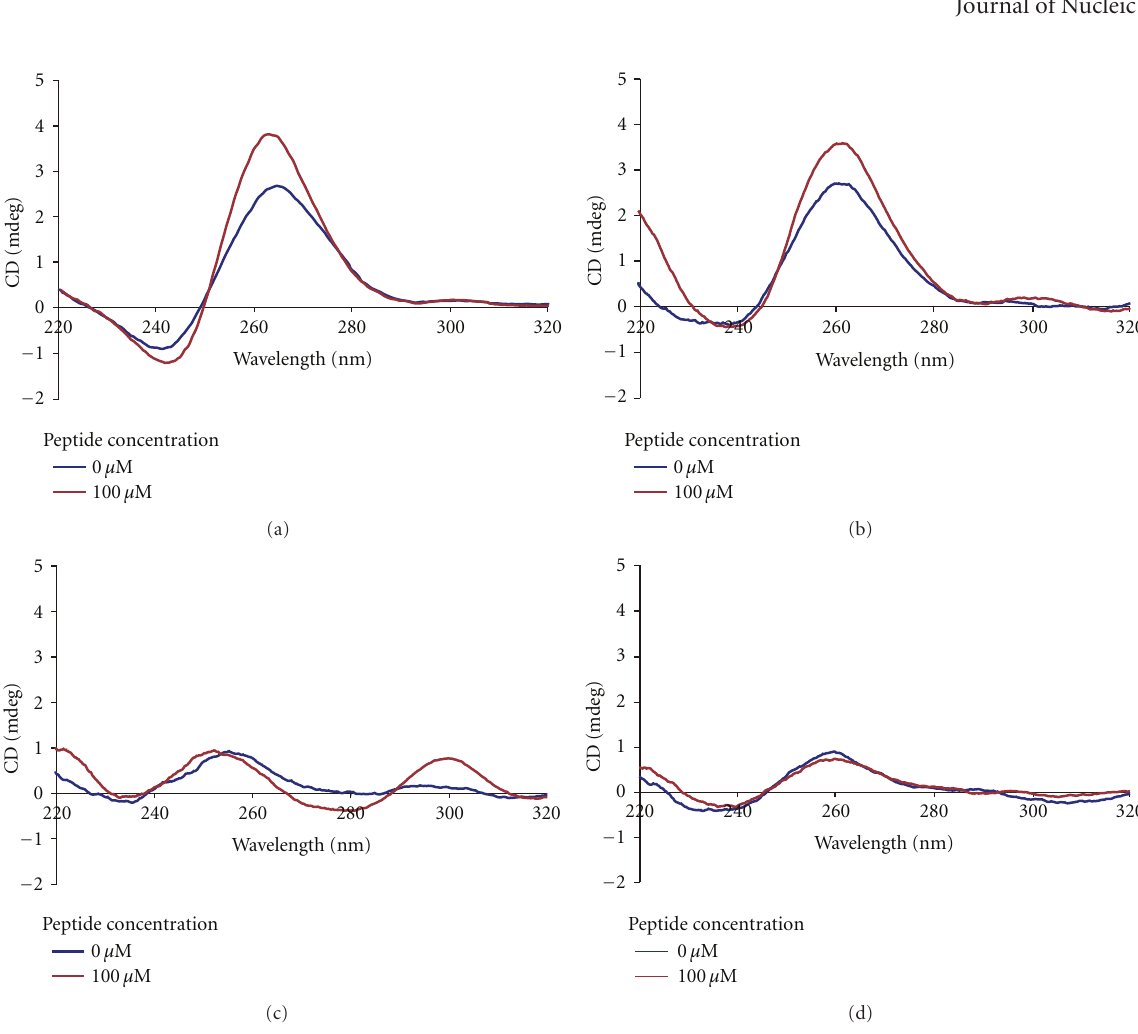
Figure 5: CD spectra of (a) MYC, (b) FGF, (c) NRAS, and (d) WNT with/without peptide no.